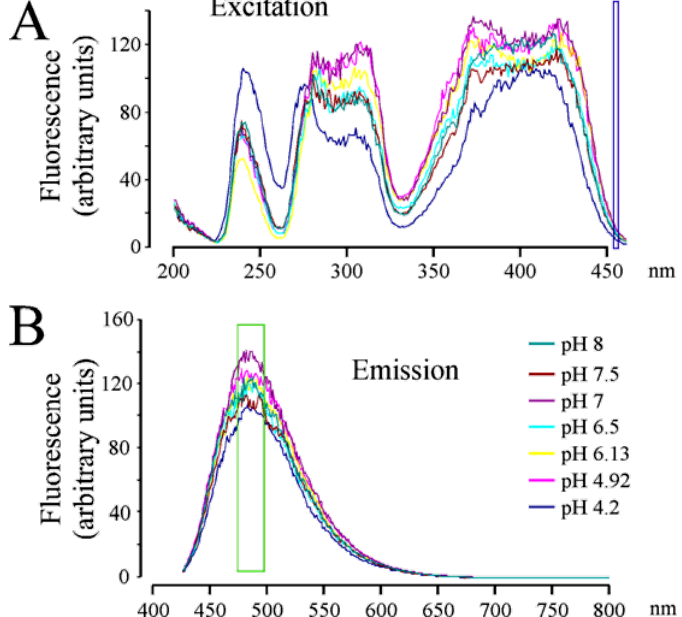
Figure 1. Fluorescent spectra of RCTM-3. ( A ). Excitation spectra showing three peaks at 240, 320 and 425 nm. The blue rectangle identifies the portion of the spectra illuminated by the laser used for TIRF microscopy; ( B ). Emission spectra, the green rectangle indicates the portion of the spectra selected by the band-pass filter used for TIRF microscopy. The colored lines indicate the fluorescent spectra obtained at different pH’s.